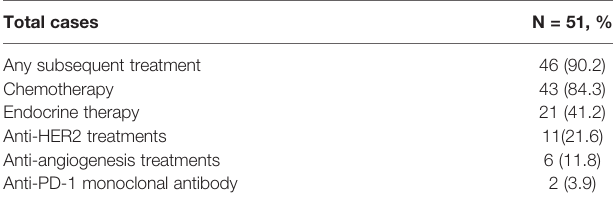
TABLE 4 | Summary of subsequent line